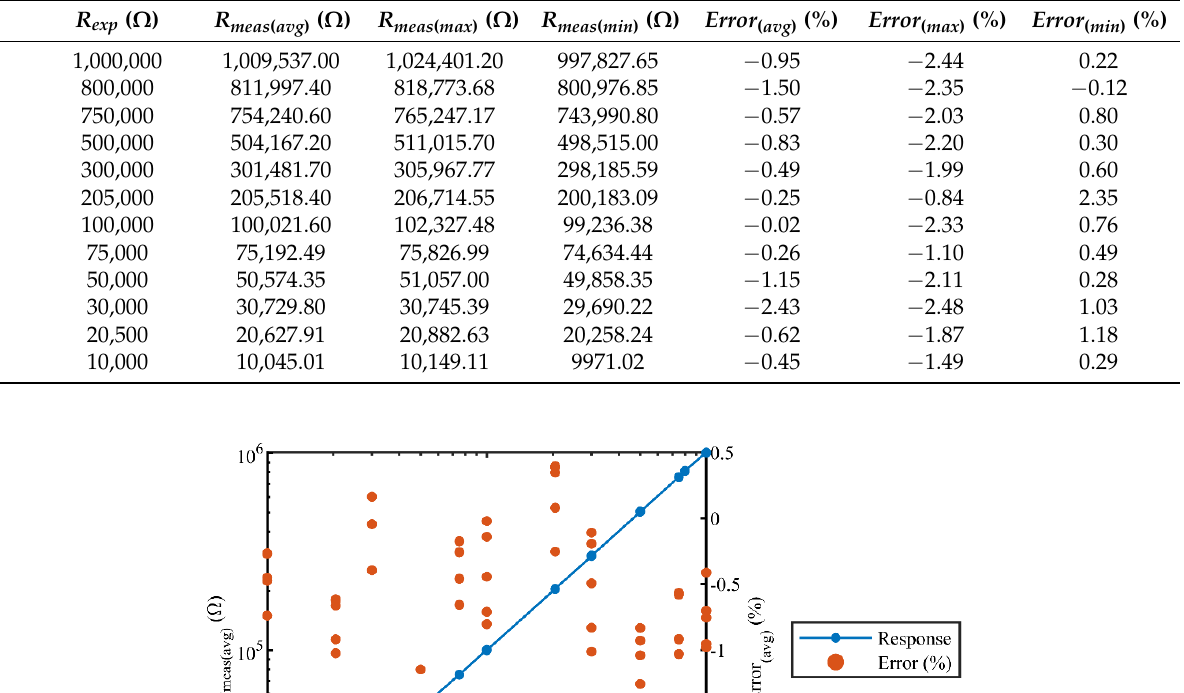
Table 3. Sixty sensor readings—expected versus measured sensor resistances.